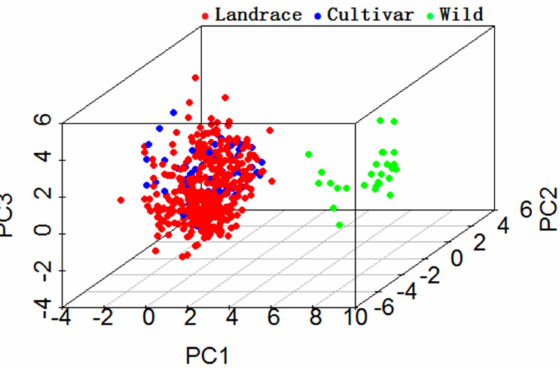
Figure 4. Principal component analysis (PCA) was conducted on 10 traits for the 475